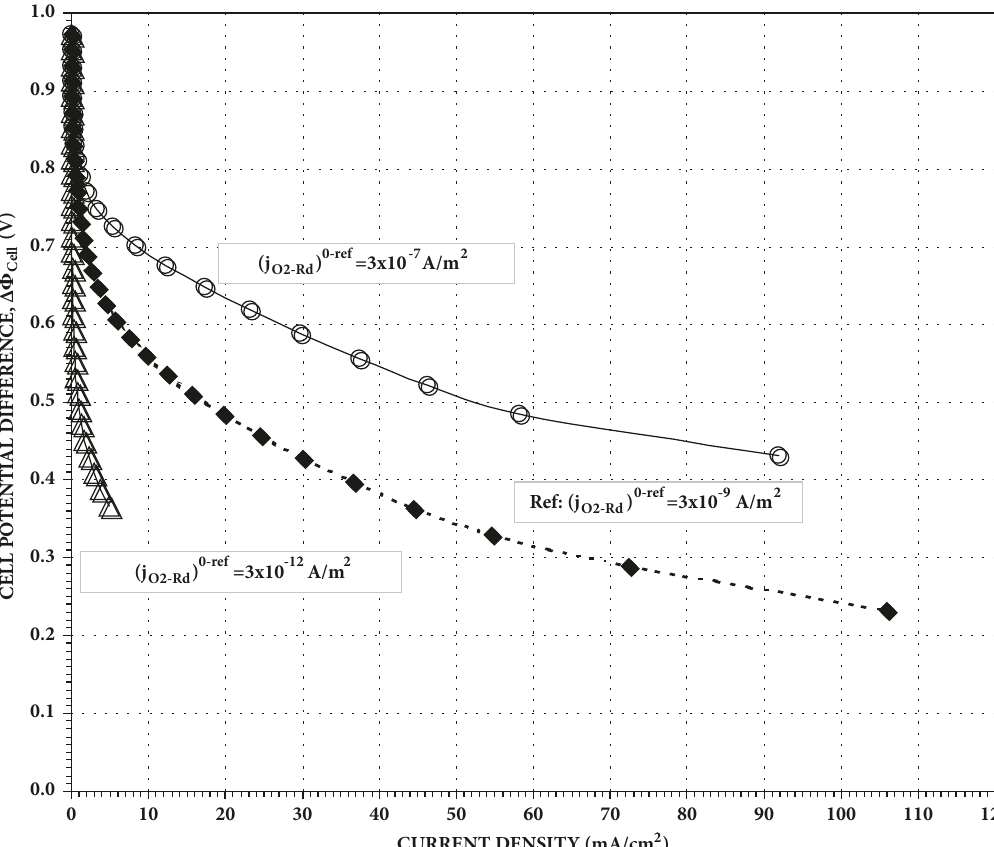
) 0 - ref (A/m 2 ), on the polarization curve for a direct propane fuel Figure 4: The effect of the cathode referenceexchange currentdensity, j ( O 2 - Rd ) 0 - ref (A/m 2 )for theabovethree caseswere representedby the following symbols: (i) cell(DPFC)model at150 ∘ Cand 1 atm. Thevaluesof j ( O 2 - Rd open circles: 3x10 −7 A/m 2 , (ii) solid diamonds: 3x10 −9 A/m 2 (reference case), and (iii) open triangles: 3x10 −12 A/m 2 . All the other parameters were the same as the reference case mentioned in Table